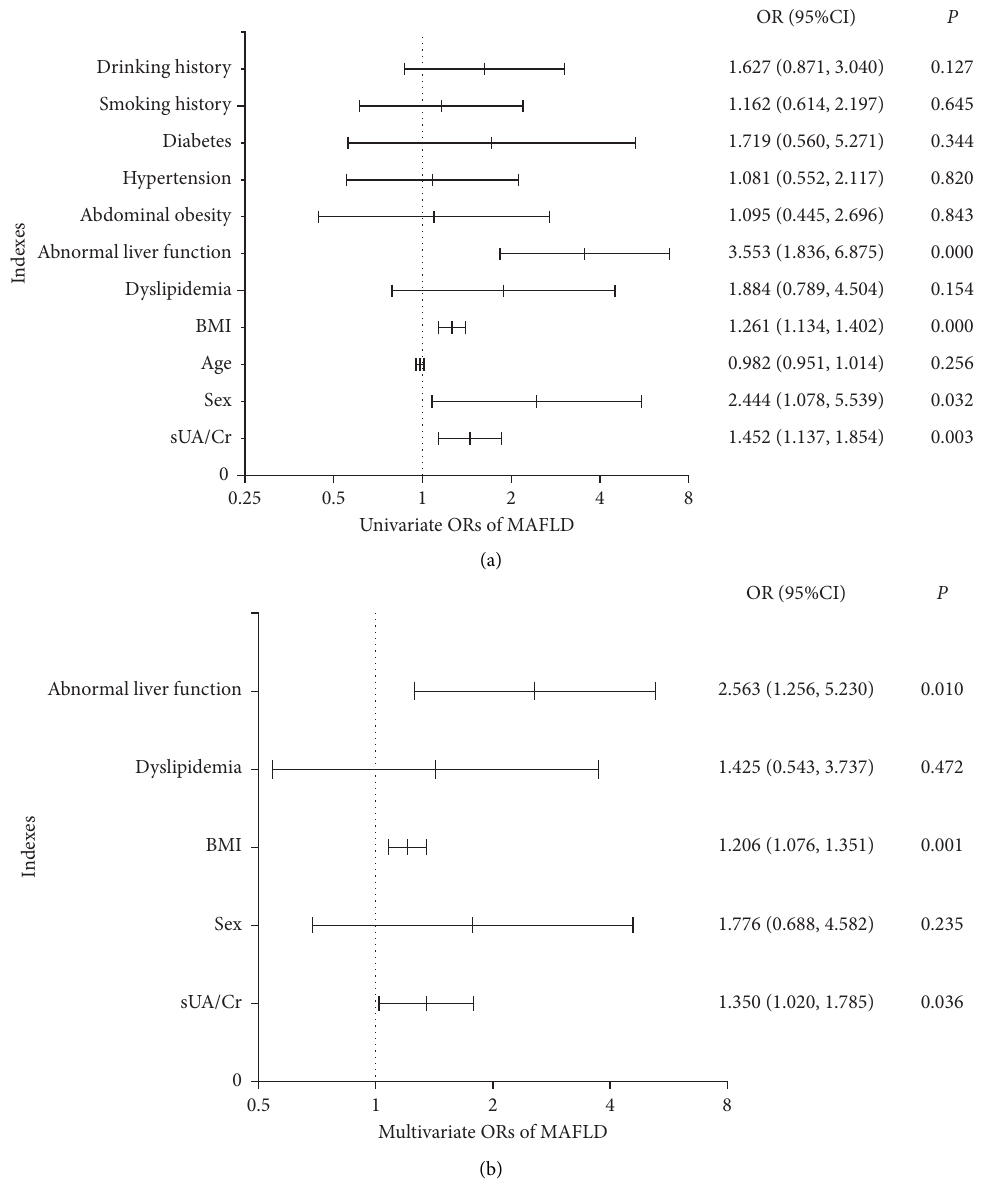
Figure 1: Te univariate and multivariate analysis. (a) Univariate odds ratios of metabolic dysfunction-associated fatty liver disease. (b) Multivariate odds ratios of metabolic dysfunction-associated fatty liver disease. Logistic regression analysis was used to assess the relationship between serum uric acid to serum creatinine ratio and moderate-severe metabolic dysfunction-associated fatty liver disease. ORs, odds ratios; BMI, body mass index; sUA/Cr, serum uric acid to serum creatinine ratio; MAFLD, metabolic dysfunction-associated fatty liver